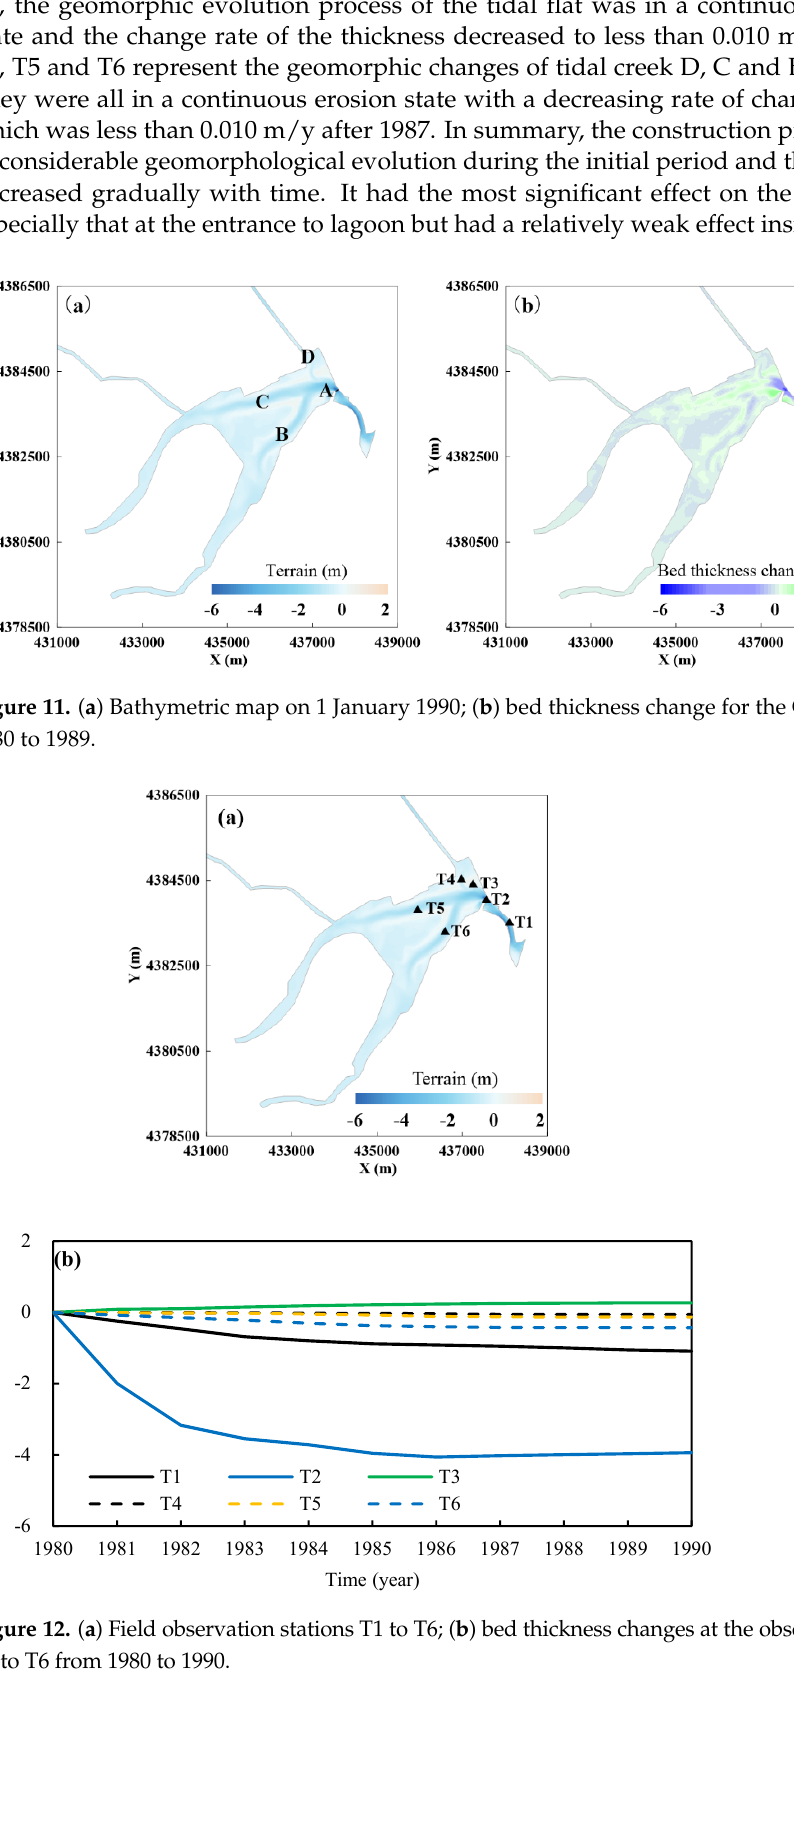
Figure 10. The average erosion (blue dashed line), deposition (red dashed line) and net deposition (solid black line) per unit area for the QL system from 1970 to 1979.